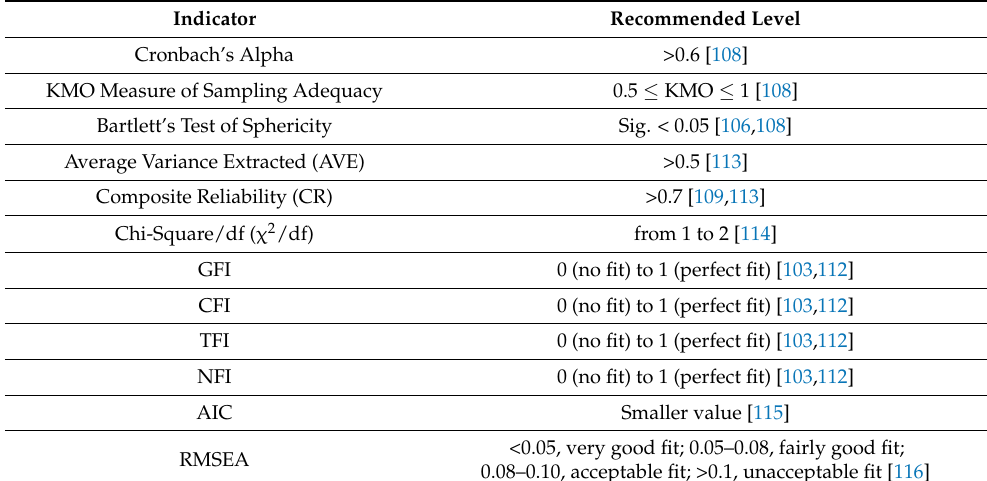
Table 2. Threshold of goodness-of-fit assessment and model